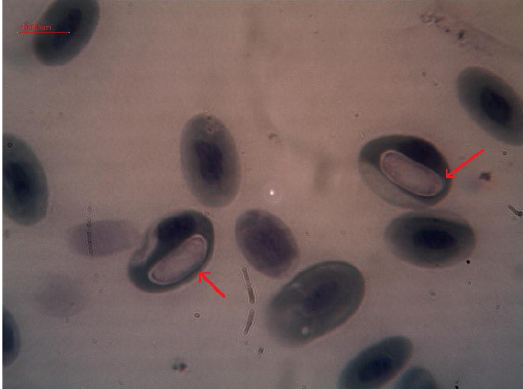
Fig. 1. Hepatozoon sp. in blood cells of